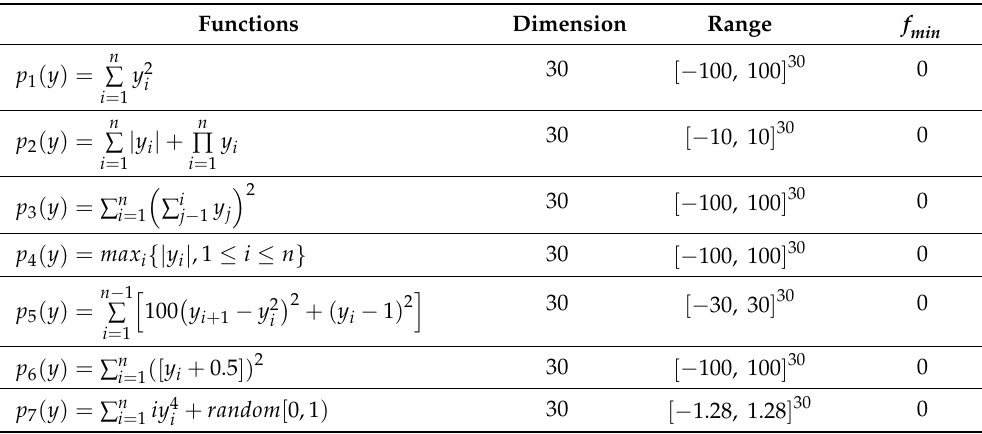
Table 1. Unimodal benchmark function.